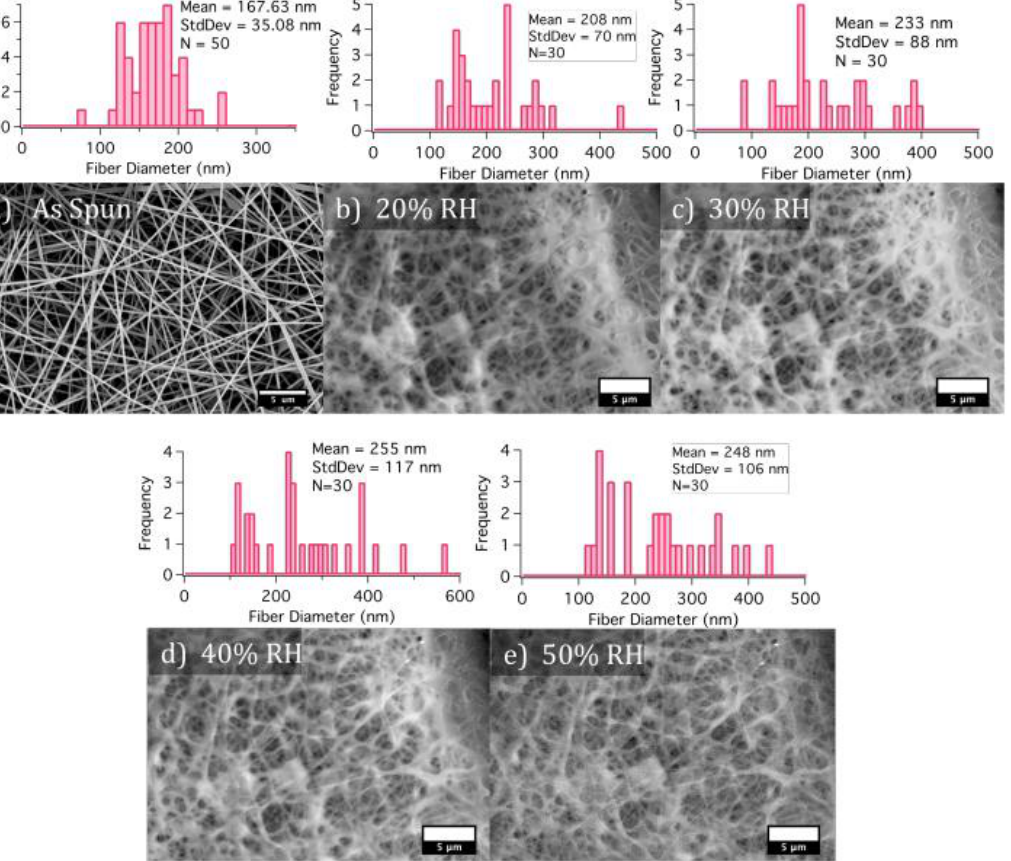
Figure 8. SEM micrograph (a) of the composite fibers imaged right after they were electrospun. Images (b–e) are ESEM micrographs of the composite fibers experiencing different ambient moisture